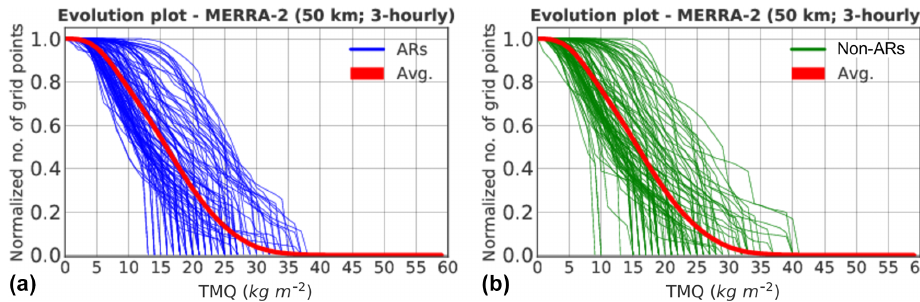
Figure 10. Normalized evolution plots of averaged (red curves) and 100 arbitrarily selected topological feature descriptors of ARs (blue curves; a ) and non-ARs (green curves; b ) for 3-hourly temporal resolution and 50km spatial resolution of the MERRA-2 reanalysis data. The plots illustrate how topological descriptors vary versus IWV. They show the topological representation of both AR and non-AR events for MERRA-2 reanalysis data.